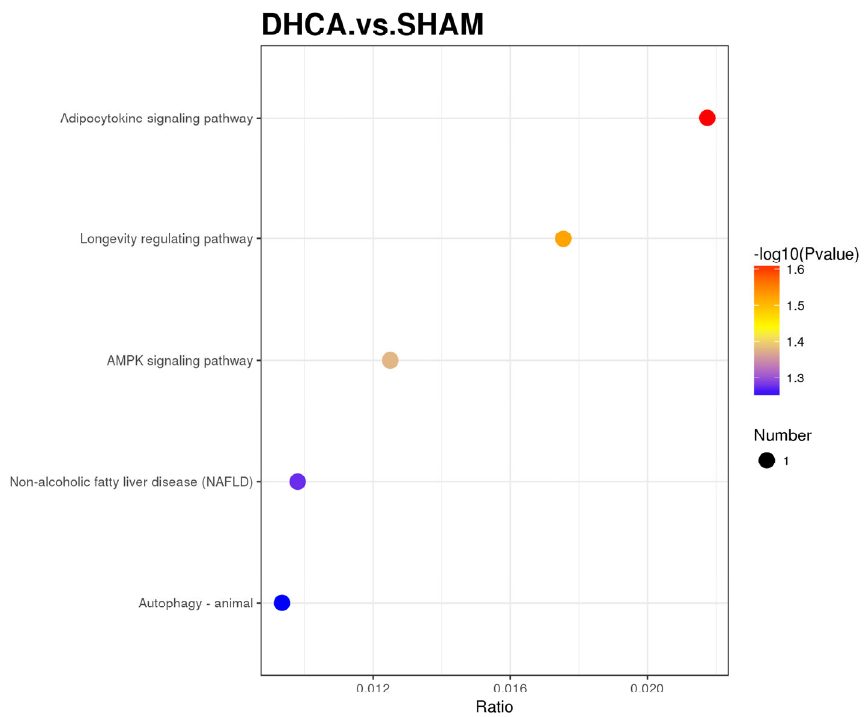
Figure 2. KEGG pathway enrichment analysis of upregulated proteins in the hippocampus of DHCA rats.